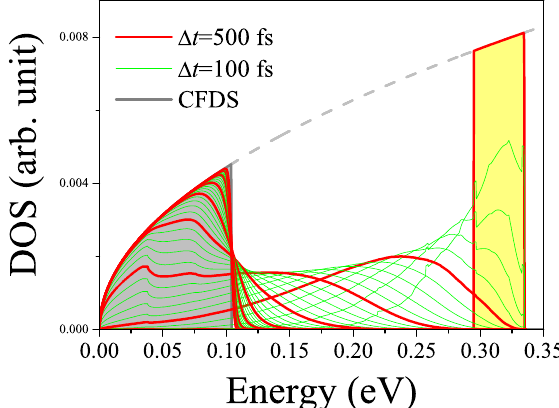
Figure 3. The time evolution of the density of states (DOS) is shown. CFDS represents the DOS at the completely Fermi degenerated state. Thick and thin lines are plotted at every 500 and 100 fs, respectively, from t = 0–4000 fs. Adapted with the permission from [11], copyright Journal of the Physical Society of Japan, 2015.